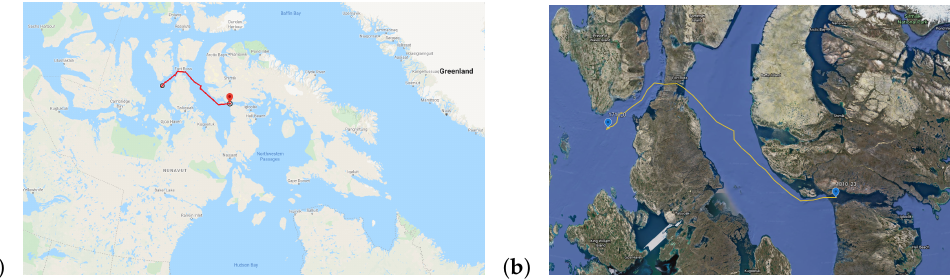
Figure 8. Route on 17–18 October 2019: larger view ( a ) and zoomed view ( b ) (via Google Earth ® ).